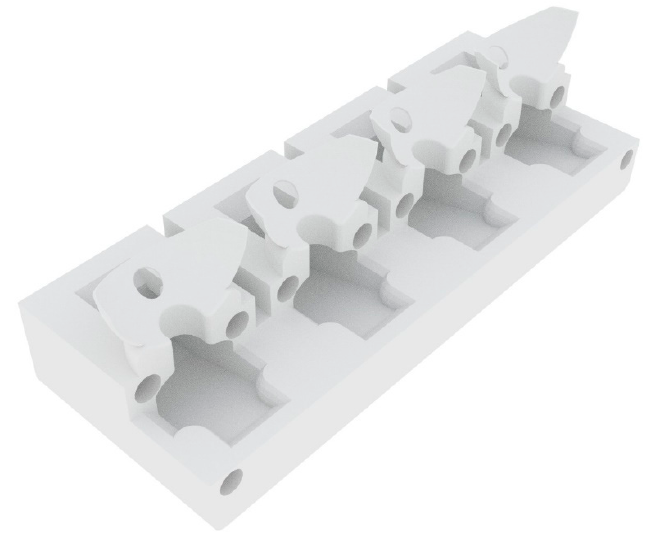
Figure 2. The collection unit allows the fluid to flow from the lower eyelid into the tray located beneath the